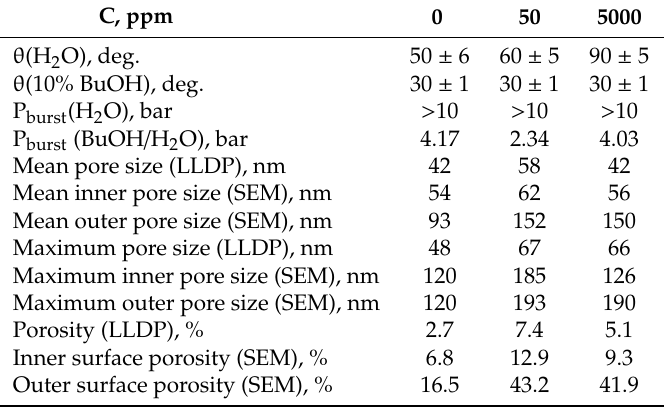
The dependence of the hollow fiber membrane properties from the active chlorine concentration (C) and pH value after treatment with the hypochlorite solution. “0” stands for the initial, untreated